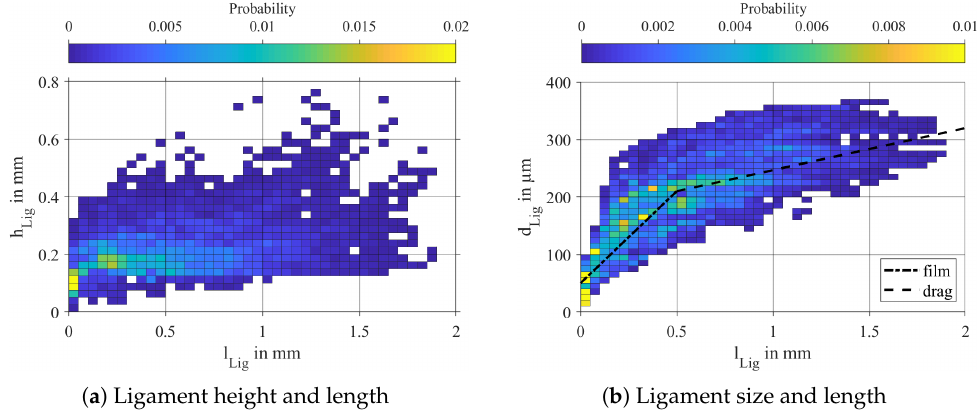
Figure 8. Interdependencies between ligament length scales for p g = 5bar, u g = 70m/s, h a = 230µm